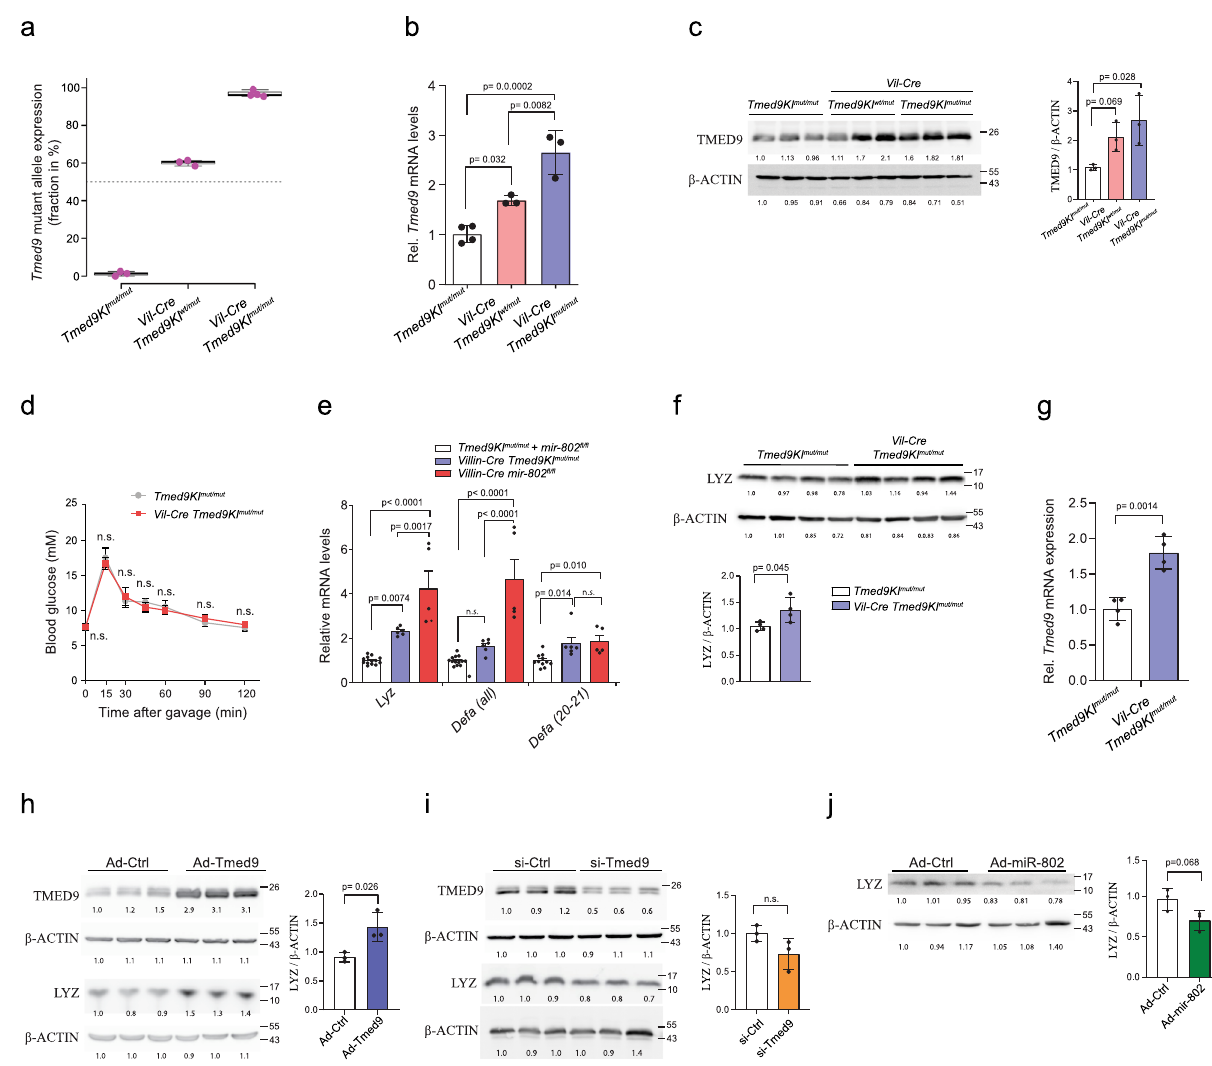
Fig. 6 Mutation of miR-802 binding sites in Tmed9 is suf fi cient to phenocopy the Vil-Cre mir-802 fl / fl Paneth cell phenotype. a Fraction (%) of Tmed9 mutant allele expression on Tmed9 expression in the intestinal epithelium of Vil-Cre Tmed9KI mut/mut , Vil-Cre Tmed9KI wt/mut , and control Tmed9KI mut/mut mice. Box plot de fi ned by minima (0, 58.43, 95.46), median (1.377, 60.55, 96.21), maxima (2.5, 61.39, 98.98), 25% percentile (0,58.43, 95.6), 75% percentile (2.5, 61.39, 98.33), range (2.5, 2.957, 3.520), mean (1.292, 60.12, 96.71) for genotypes Tmed9KI mut/mut ,Vil-Cre Tmed9KI wt/mut , Vil-Cre Tmed9KI mut/mut respectively with line shown at mean ( n = 3, 3, 4 respectively per genotype). b Relative mRNA expression, measured by qRT-PCR, of Tmed9 in the isolated intestinal epithelium of Vil-Cre Tmed9KI mut/mut , Vil-Cre Tmed9KI wt/mut , and control Tmed9 mut/mut mice ( n = 3,3,4 for each genotype respectively). Data are representative of three independent experiments. c Immunoblot analysis of TMED9 in the jejunum of Vil-Cre Tmed9KI mut/mut Vil-Cre Tmed9KI wt/mut , and control Tmed9KI mut/mut mice. β -ACTIN was used as a loading control. Quantitative densitometric analysis is shown on the right. Each lane represents a lysate from a different mouse ( n = 3 per genotype). Data are representative of two independent experiments. d Oral glucose tolerance test of Vil-Cre Tmed9KI mut/mut and control Tmed9KI mut/mut mice ( n = 7 for each group, two independent experiments). e Relative mRNA expression levels, measured by qRT-PCR, of antimicrobial peptides in jejunum of Vil-Cre Tmed9KI mut/mut and Vil-Cre mir-802 fl / fl compared to control mice ( Tmed9KI mut/mut and mir-802 fl / fl ) ( n = 13, 6, 5 for Tmed9KI mut/mut and mir-802 fl / fl , Vil-Cre Tmed9KI mut/mut , and for Vil-Cre mir-802 fl / fl , respectively for each group). Data are representative of two independent experiments. f Immunoblot analysis of LYZ in isolated enterocytes from upper jejunum of Vil-Cre Tmed9KI mut/mut and Tmed9KI mut/mut littermates. The quanti fi cation of densitometric analysis is shown on the right. Each lane represents a lysate from a different mouse ( n = 4 per genotype, two independent experiments). g Tmed9 transcript levels, measured by qRT-PCR, in FACS-sorted Paneth cells of Vil-Cre Tmed9KI mut/mut mice compared to Tmed9KI mut/mut controls ( n = 4 per genotype, one experiment). h , i Immunoblot analysis of LYZ in C2BBe1 cells that were infected with Ad- Tmed9 ( h ) or transfected with siRNAs targeting Tmed9 or control siRNAs ( i ). β -ACTIN was used as a loading control. Quantitative densitometric analysis is shown on the right ( n = 3 per group, one experiment). j Immunoblot analysis of LYZ in C2BBe1 cells infected with Ad-miR-802 and control (Ad-GFP) adenovirus. β -ACTIN was used as a loading control. Quantitative densitometric analysis is shown on the right ( n = 3 per group). Data are representative of two independent experiments. Data are plotted as mean ± SD. Statistical signi fi cance was evaluated by descriptive statistics ( a ) unpaired two-tailed t -tests ( f – j ), by one-way ANOVA followed by Tukey ’ s multiple comparison test ( b , c , e ), or two-way ANOVA for repeated measures with Sidak ’ s multiple comparisons test ( d